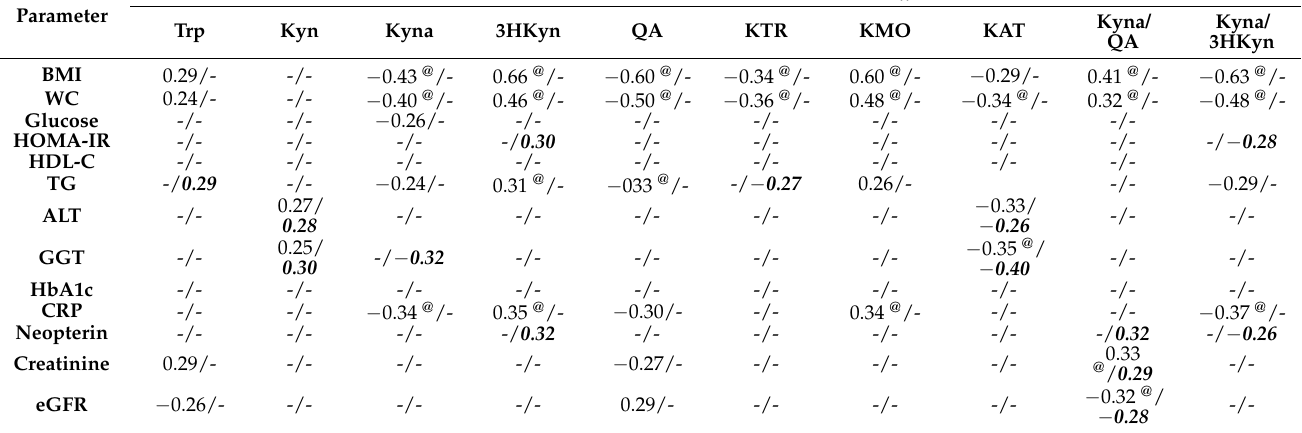
Table 5. The Spearman rank correlation coefficients between Trp, KP metabolites, and metabolic factors according to glycemic